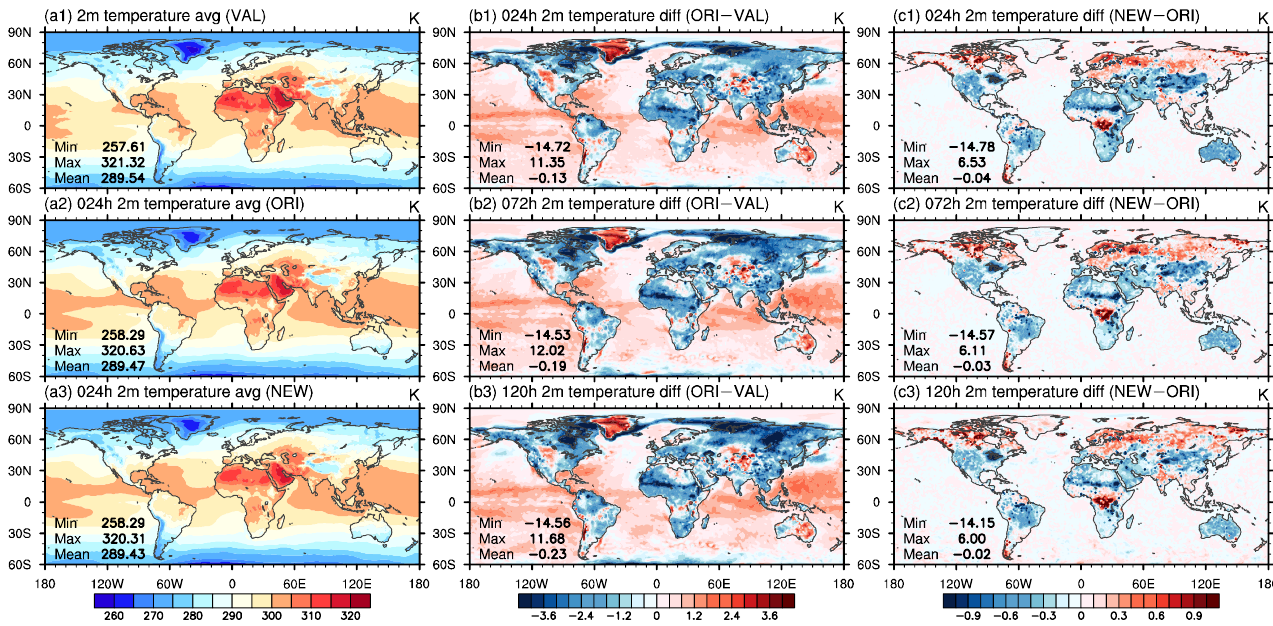
Figure 6. Same as Figure 2, but for air temperature at 2 m (units: K).